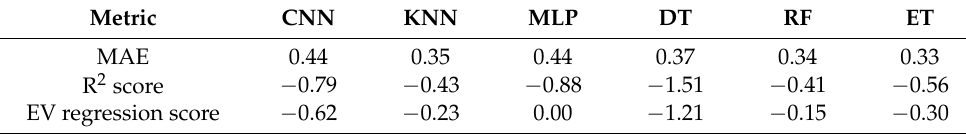
Table 13. Evaluation metrics for validation set of phase-only image